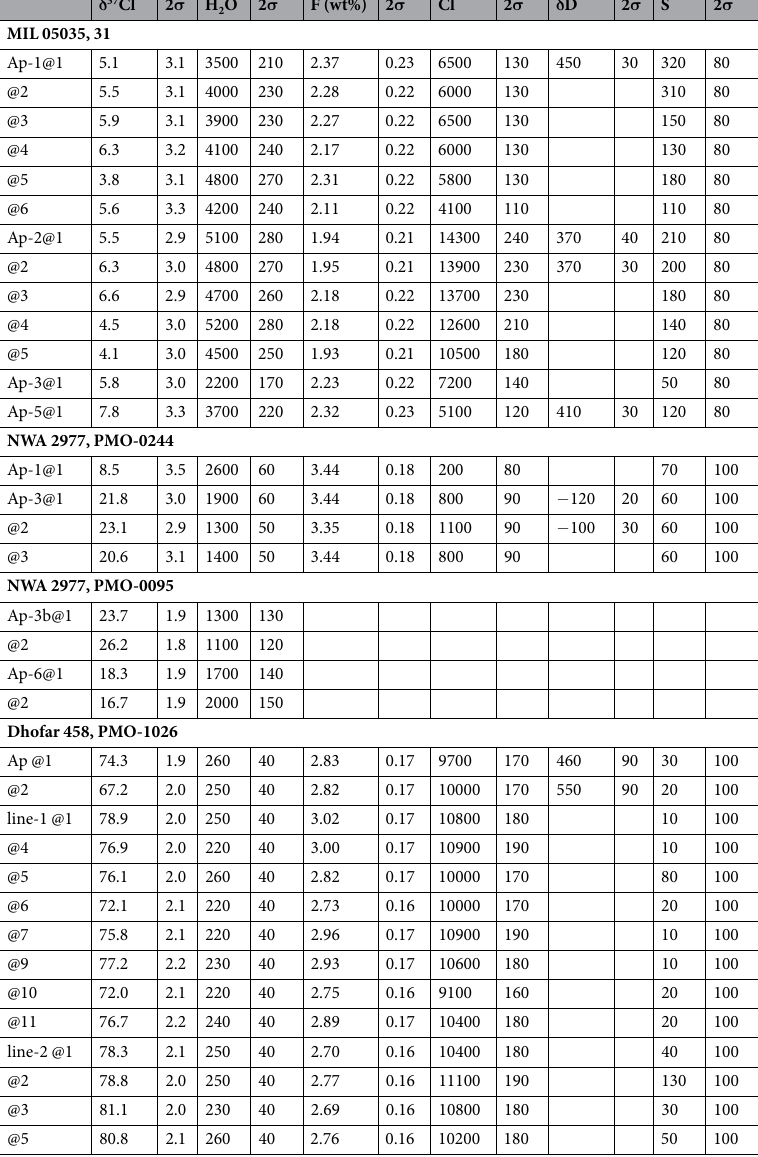
Table 1. Chemical (ppm) and isotopic (‰) compositions of volatile elements in apatite from lunar